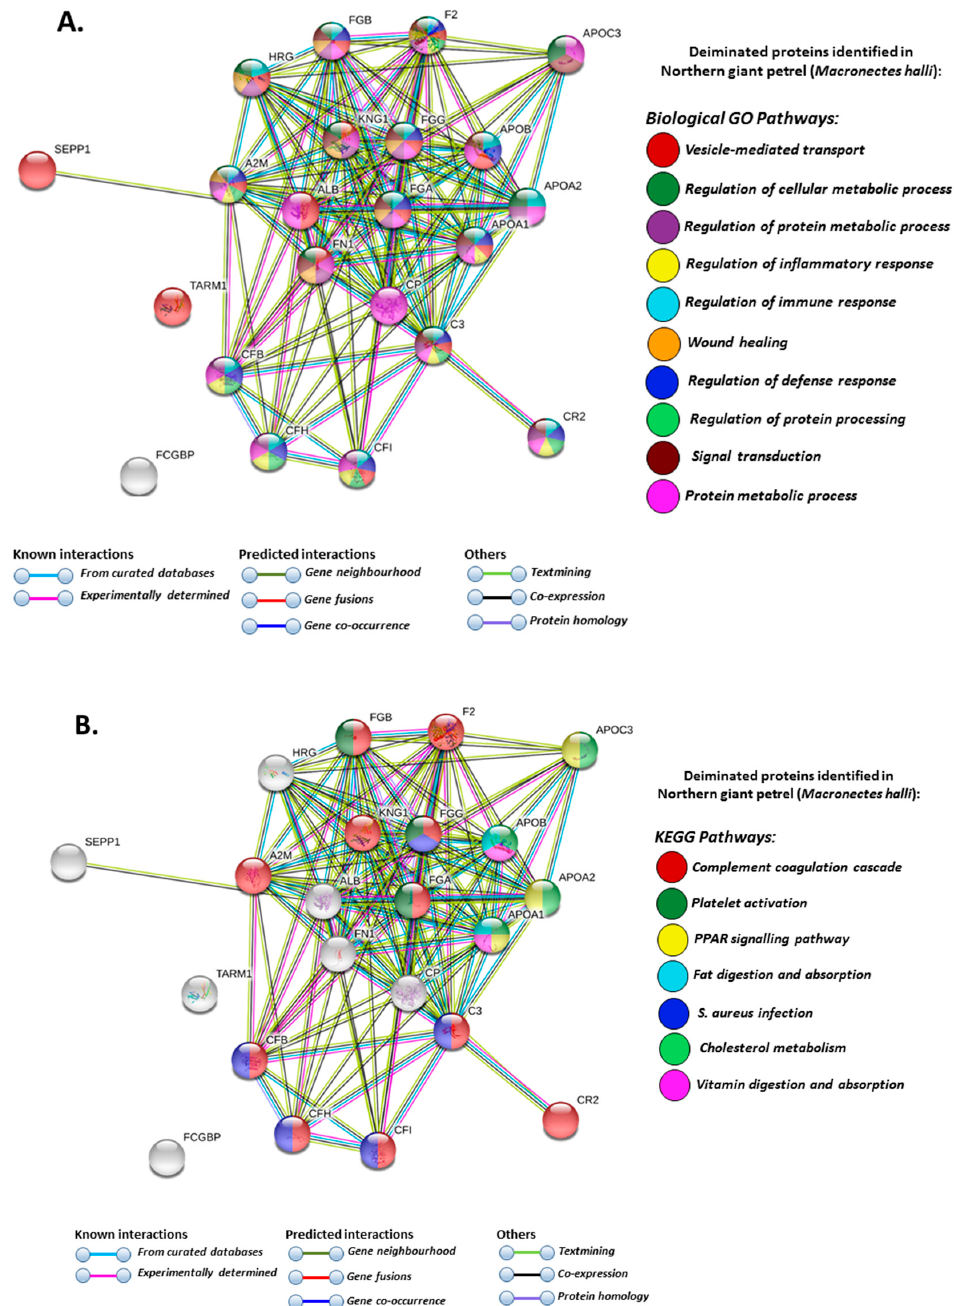
Figure 5. Protein–protein interaction networks of deiminated proteins identified by F95 enrichment in plasma of northern giant petrel ( Macronectes halli ). Reconstruction of protein–protein interactions based on known and predicted interactions of human homologue proteins to proteins identified in northern giant petrel, using Search Tool for the Retrieval of Interacting Genes / Proteins (STRING) analysis. ( A ) Biological Gene Ontology (GO) pathways relating to identified proteins and reported in STRING are highlighted showing vesicle-mediated transport; regulation of cellular metabolic process; regulation of protein metabolic process; regulation of inflammatory response; regulation of immune response; wound healing; regulation of defence response; regulation of protein processing; signal transduction; protein metabolic process. ( B ) Kyoto Encyclopedia of Genes and Genomes (KEGG) pathways relating to the identified proteins and reported in STRING are highlighted showing complement and coagulation cascade; platelet activation; PPAR signalling pathway; fat digestion and absorption; Staphylococcus aureus infection; cholesterol metabolism and vitamin digestion and absorption. Coloured nodes